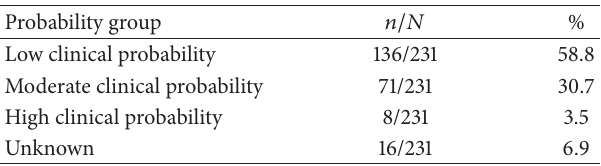
Table 3: Clinical probability groups based on Wells’